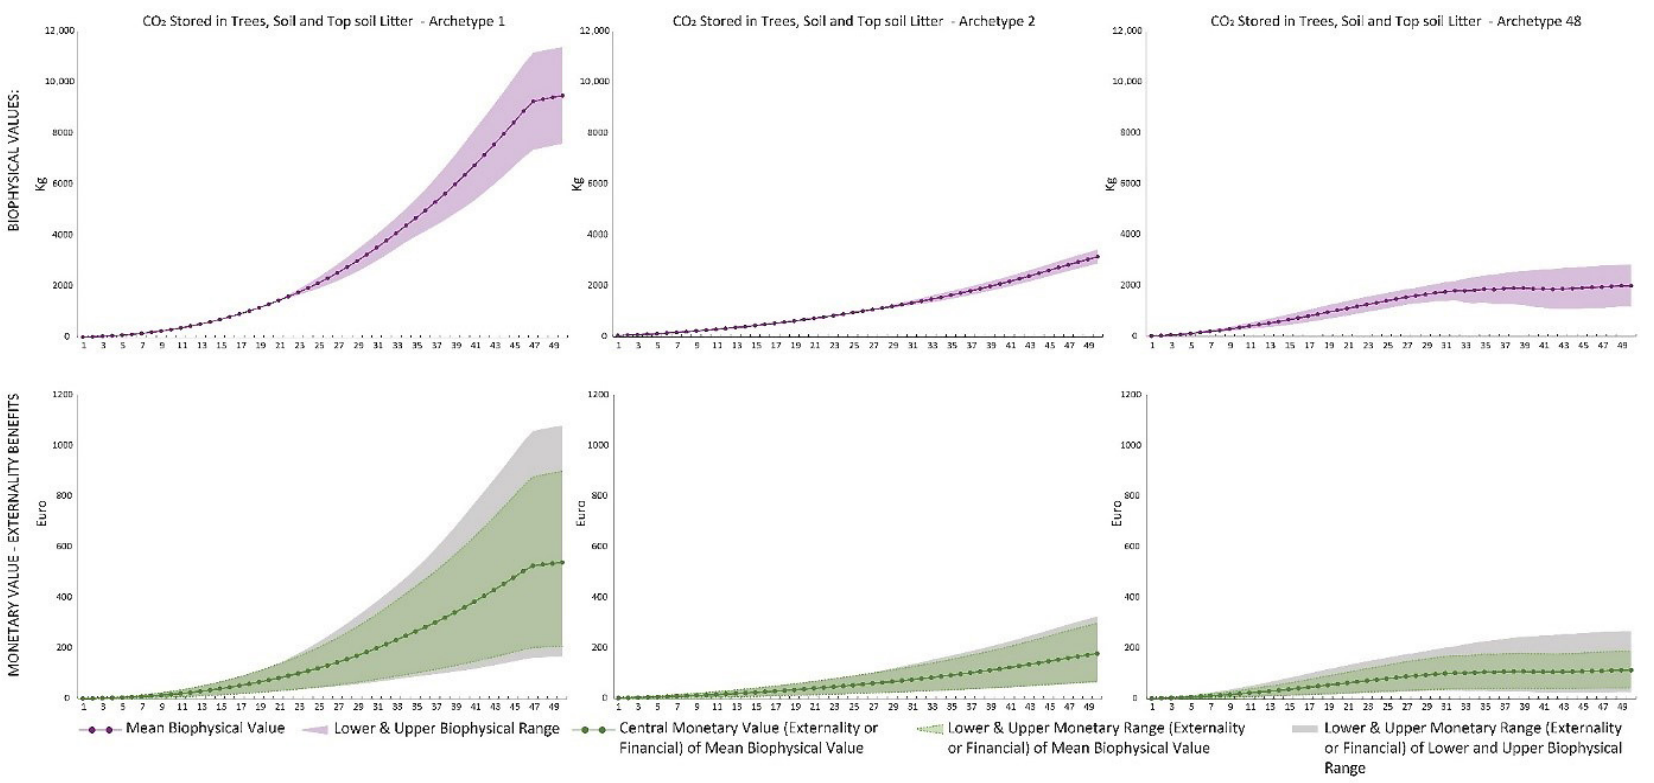
Figure 12. Comparison of biophysical and monetary performance over time for “Regulation of chemical condition of the atmosphere” in archetypes 1, 2, and 48. Results are shown as cumulative values over time (i.e., value at year 50 is the accumulated value from year 1 to 50).